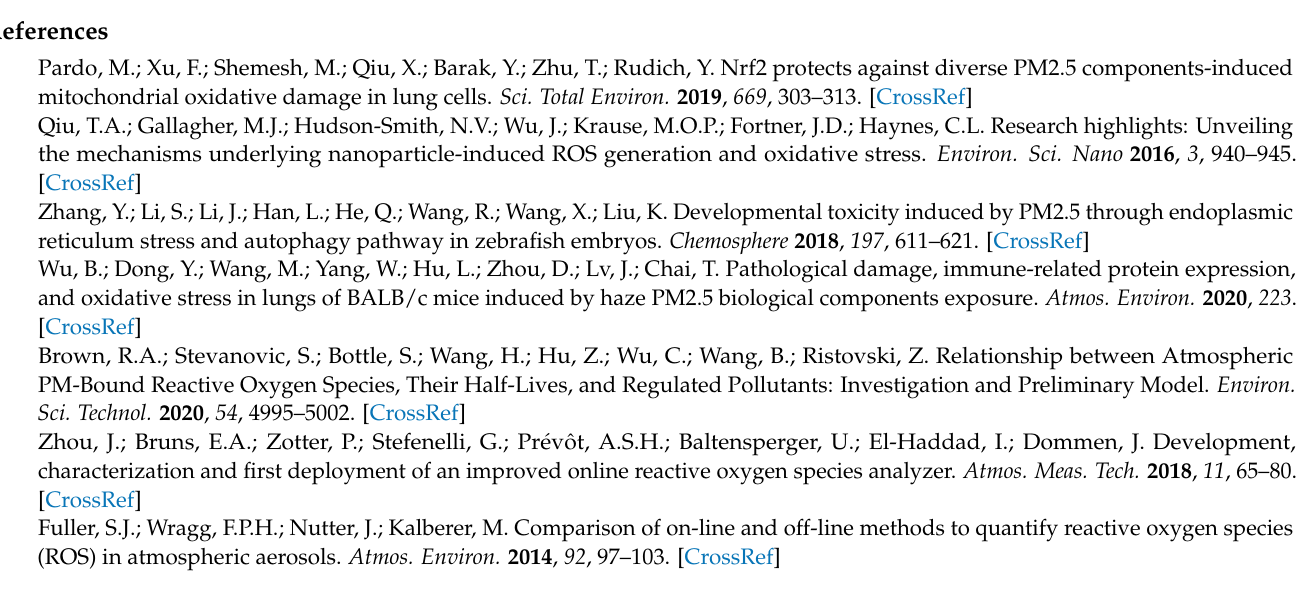
settings; Table S2: Experimental results of fluorescence detection precision; Table S3: Experimental results of fluorescence detection stability; Table S4: Pollutant averages for the second quarter of 2021; Table S5: The data of AQI etc. at the same stage of sampling for the detection of free